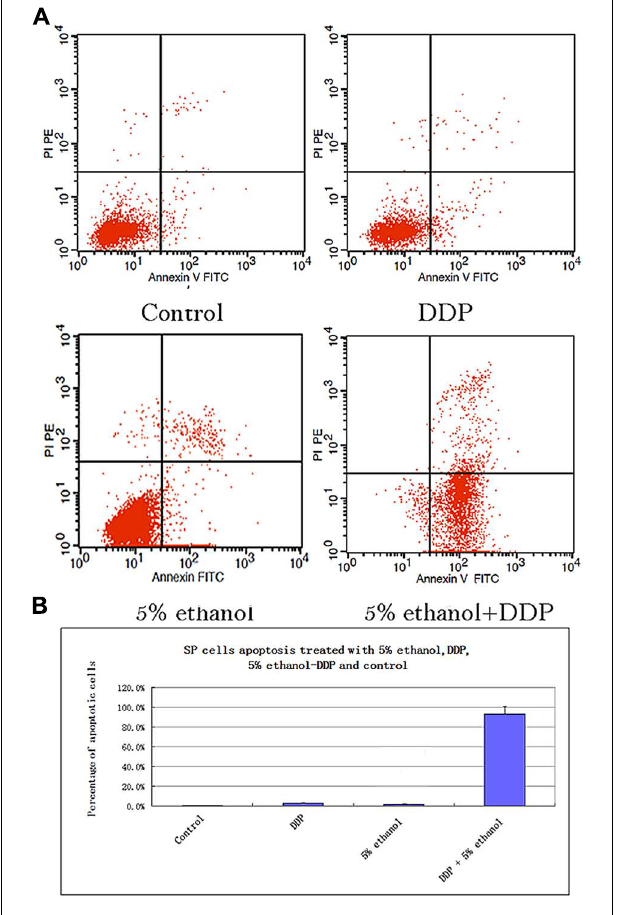
FIGURE 2 | (A) Apoptosis analysis of SP cells treated with 5% ethanol, DDP, 5% ethanol–DDP, and control by FACS. (a) Apoptosis of control